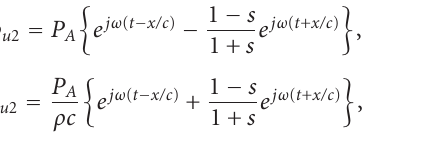
K I ) using drag , CFD-